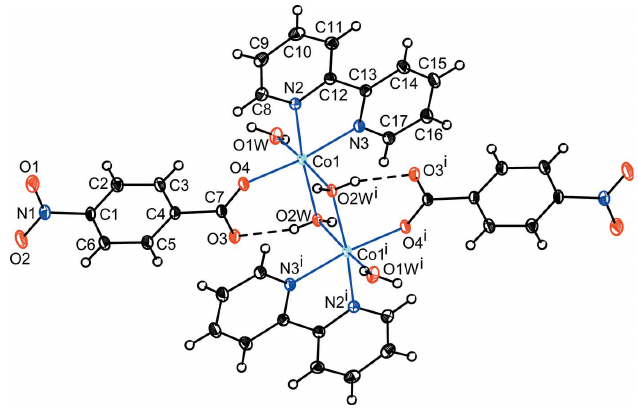
Figure 1 The dinuclear dication in 1 with displacement ellipsoids drawn at the 50% probability level. Intramolecular hydrogen bonds are shown as broken lines [Symmetry code: (i) 1 – x , 1 – y , 1 – z